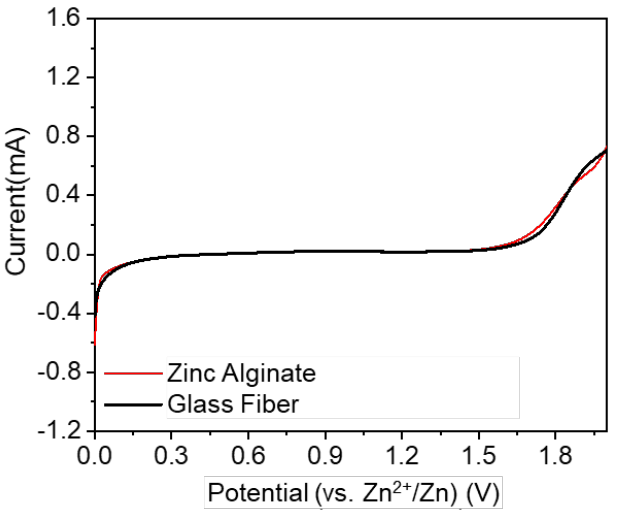
Figure 6. The linear sweep voltammograms of the ZA-based HGPE and the wet glass-fiber separa- tor.